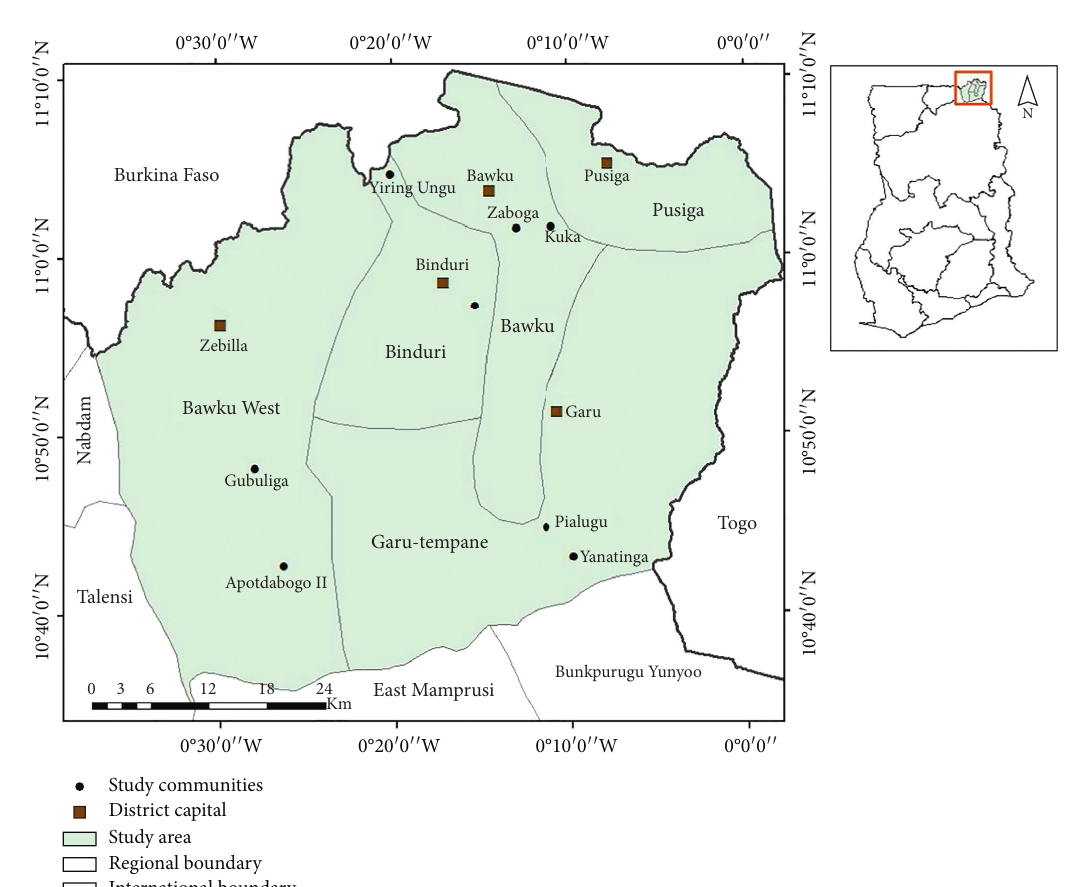
Figure 1: Study area map in regional and national context. Source: [25].